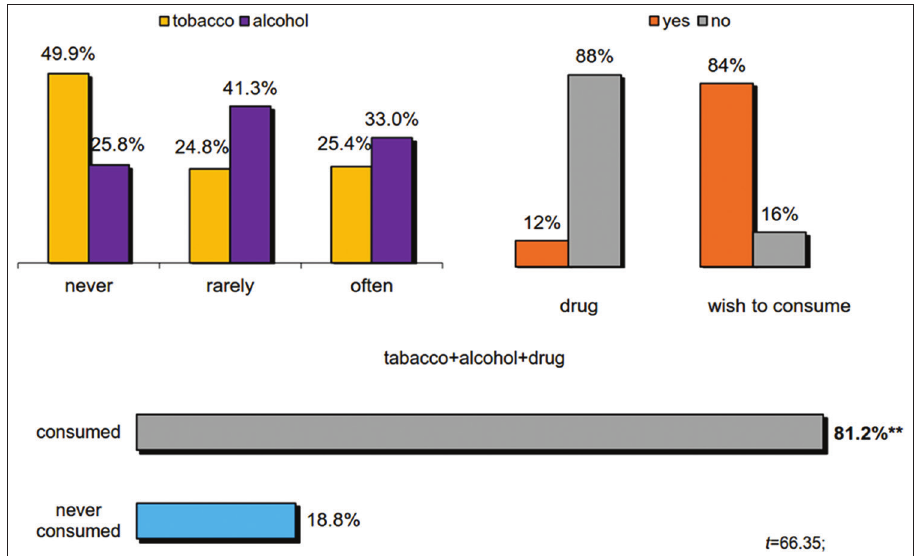
FIGURE 1. The prevalence of the consumption of tobacco, alchol, and drugs by